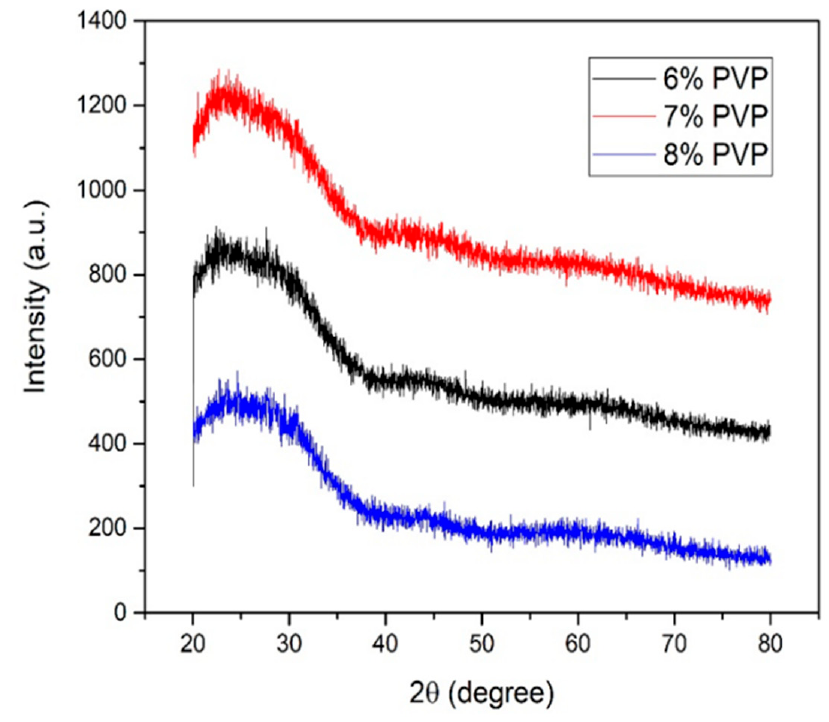
Figure 2. XRD pattern of 6, 7 & 8 wt.% PVP/TiO 2 Nanofibers.